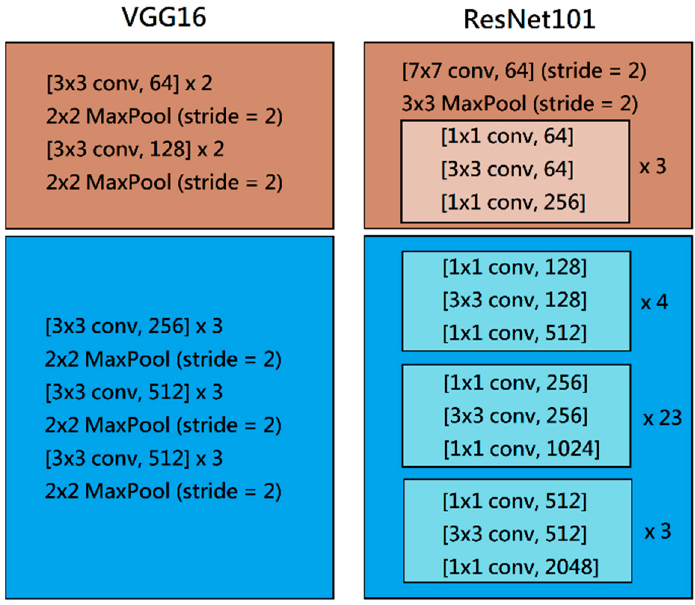
Figure 5. The usage of pre-trained convolutional neural networks (CNNs).